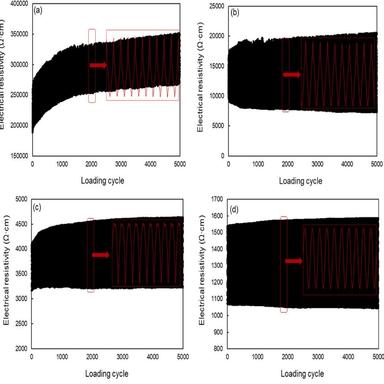
Long-term electrical resistivity change of the samples with TWCNT content of (a) 0.1, (b) 0.2, (c) 0.3, and (d) 0.5% under 5000 cycles of compressive loading.